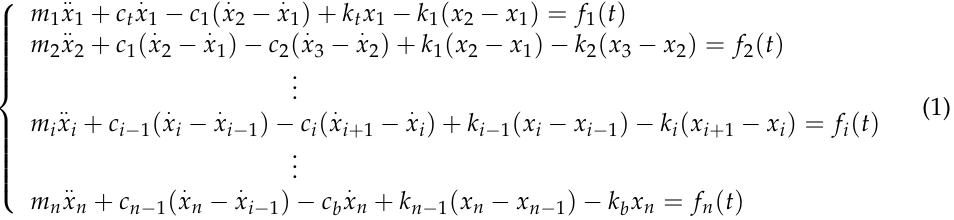
Table 1. Definition of elements in the multi-DOF model.